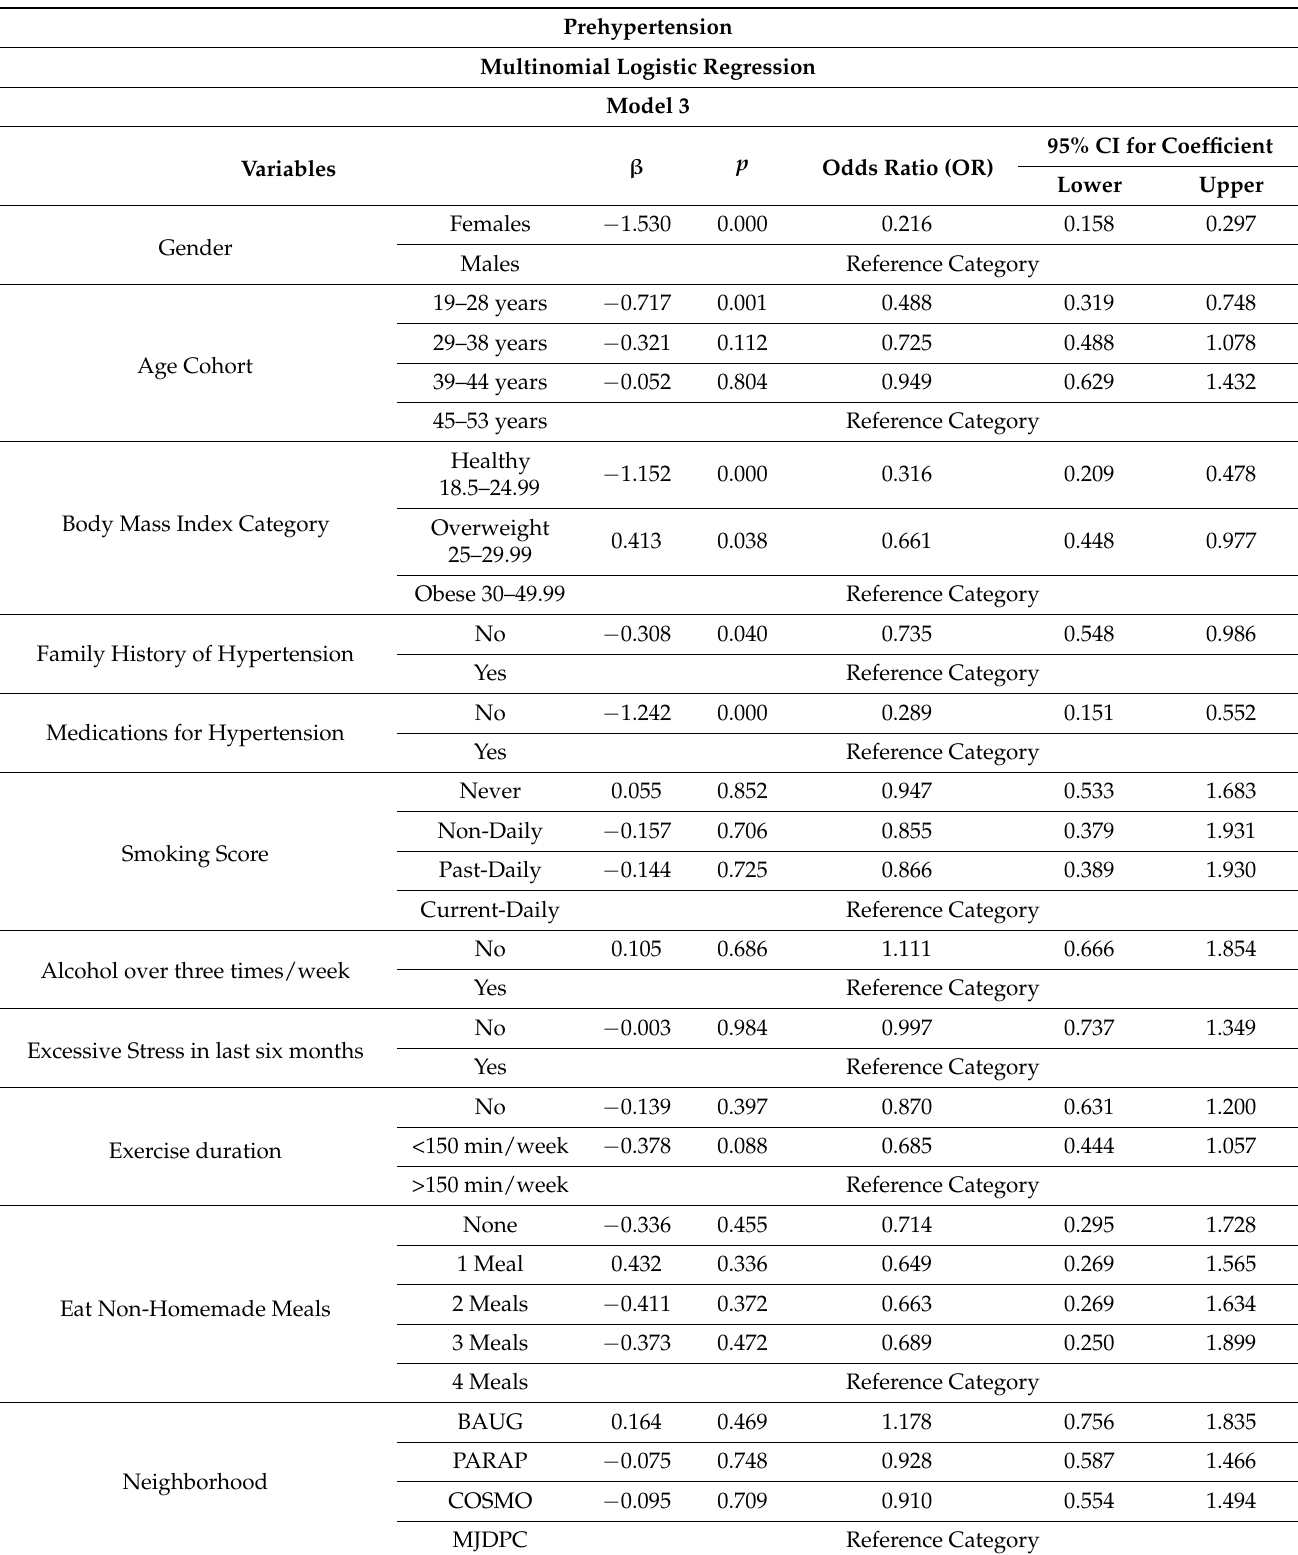
Table 5. Multinomial logistic regression for pre-hypertension and